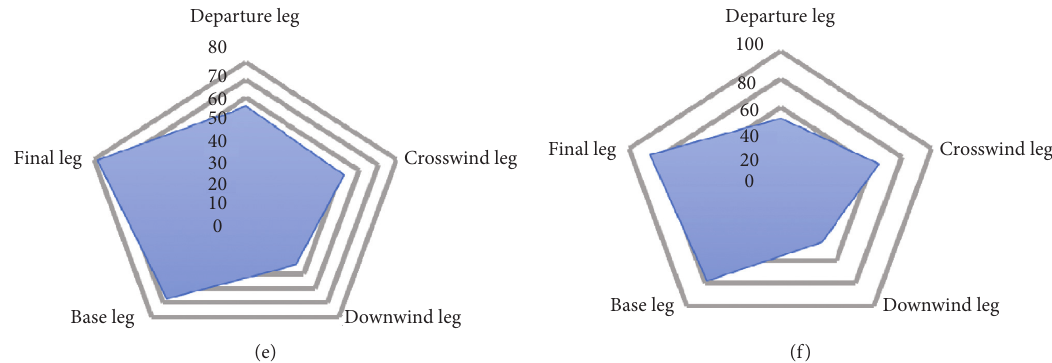
Figure 10: Radar chart of cognitive load: (a) psychological need radar chart; (b) physical need radar chart; (c) time required radar chart; (d) performance level radar chart; (e) effort level radar chart; (f) frustration level radar chart.